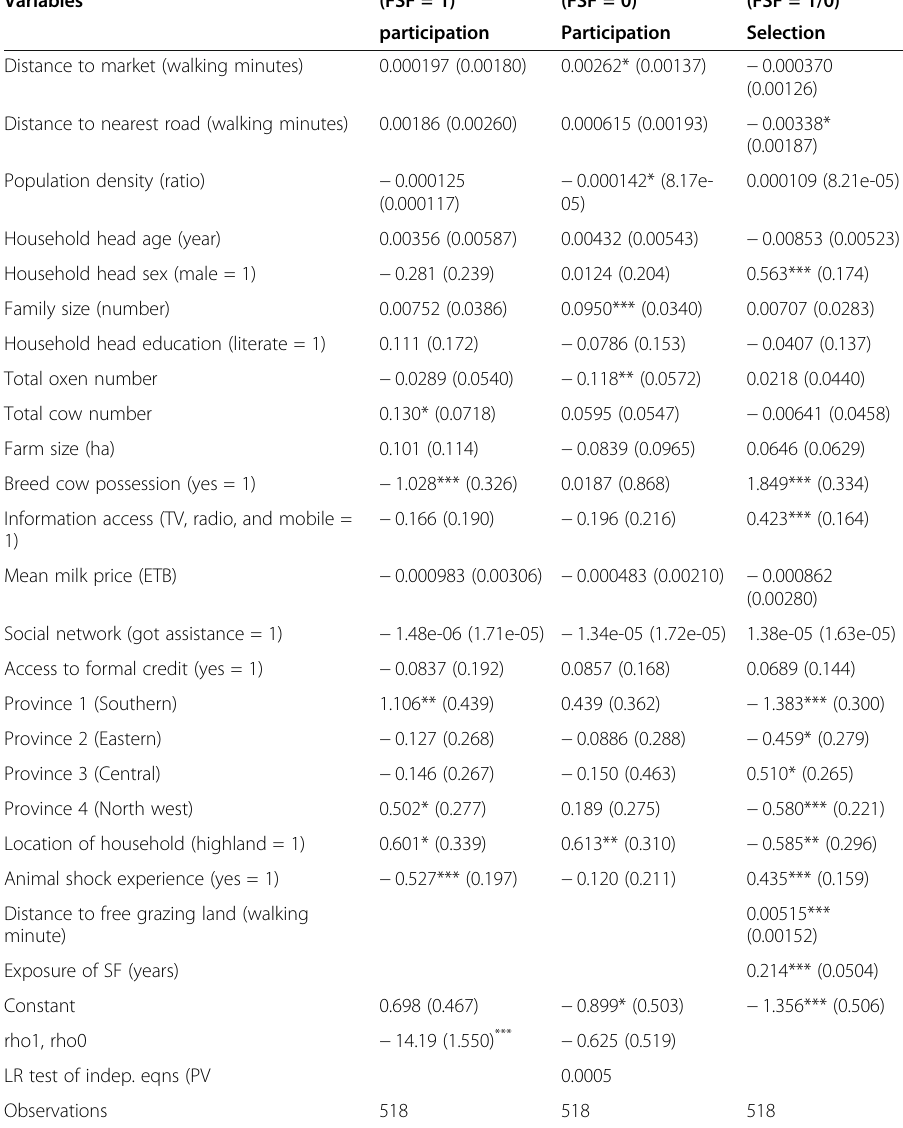
Table 6 Endogenous switching for FSF adoption and animal sale market participation